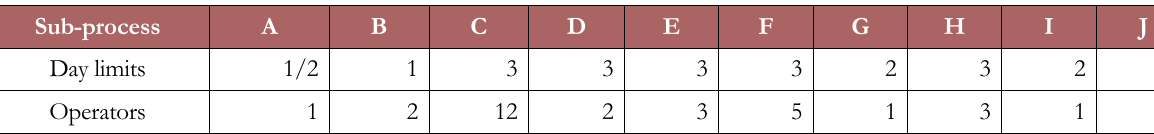
Table 16. Limit of days per sub-process